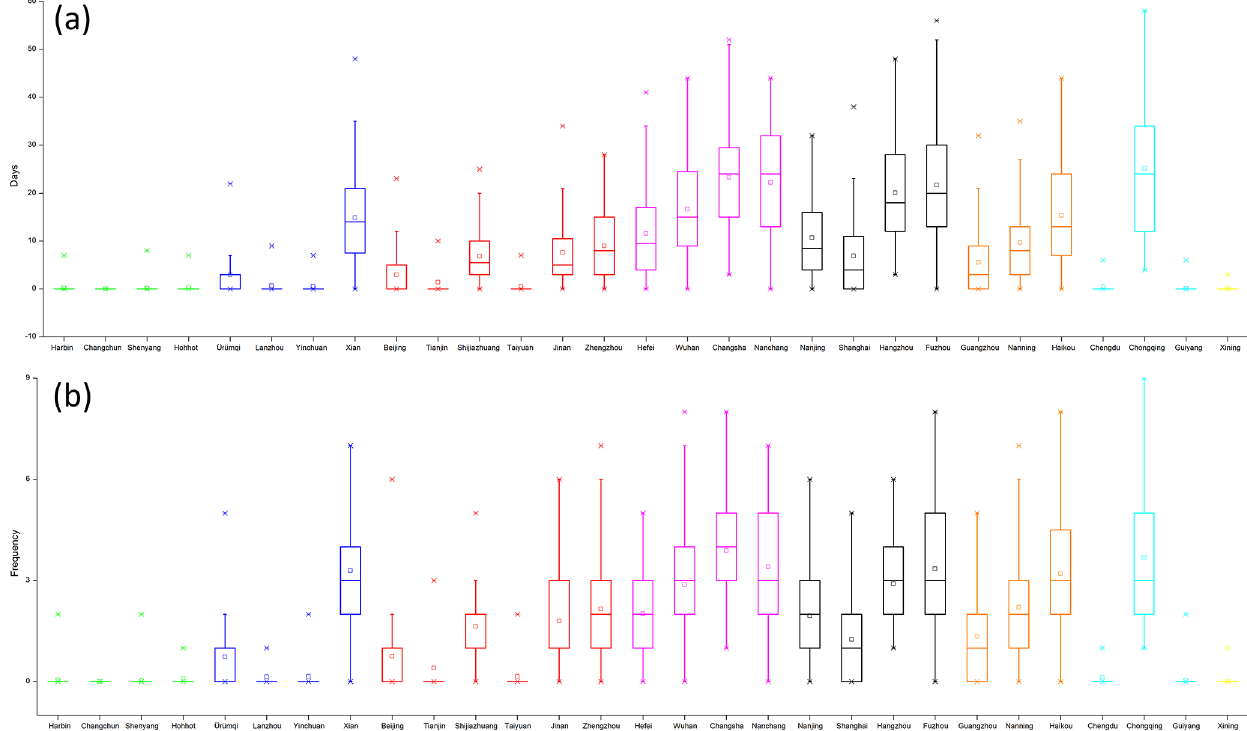
Figure 6. Distribution of number and frequency of HWs in 29 cities from 1955 to 2014 – (a) number of HWs; (b) frequency of HWs. Green color: NE; blue color: NW; red color: NC; purple color: CC; black color: EC; orange color: SC; cyan color: SW; yellow color: QT). Boxes indicate the interquartile spread (25th and 75th quantiles) with the horizontal line indicating the ensemble median and the whiskers showing the extreme range of HW frequency and number in 29 cities. There has been no high-temperature weather in which daily T max exceeds 35 ◦ in Kunming and Lhasa cities in the past 60 years. Therefore there are 29 cities shown in this figure. Table 1. The classification of HW hazards by the values of HWI. Heat wave index Level of Description hazard HWI = 1.0 No hazard No HW event occurred. The HW event must last at least 3 continuous days and fewer than 6 continuous days, of which there are no days above 37 or 40 ◦